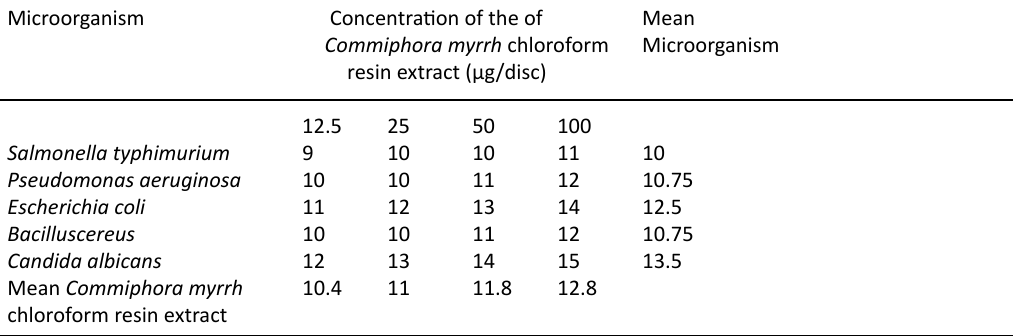
resin extract Table 10. Inhibition zone (in mm) for different concentrations of Commiphora myrrh chloroform extract Microorganism Concentration of the of